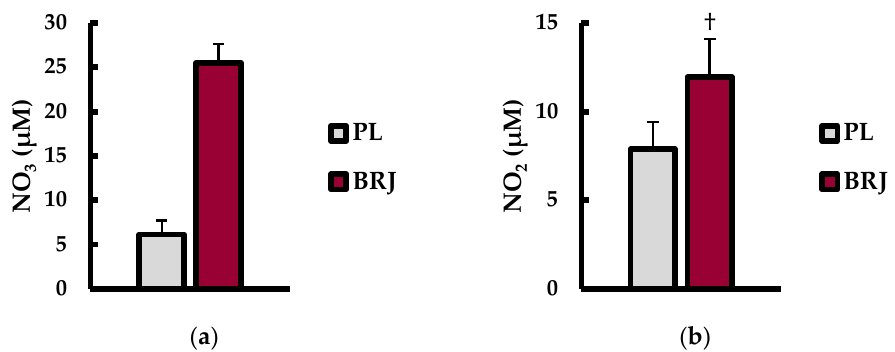
Figure 2. Changes in ( a ) Plasma Nitrate (NO 3 ; μM) and ( b ) Plasma (NO 2 ; μM) between placebo (PL; grey bars) and beetroot juice (BRJ; dark red bars). Data are presented as mean ± SD. † indicates significantly different from PL ( p < 0.05).